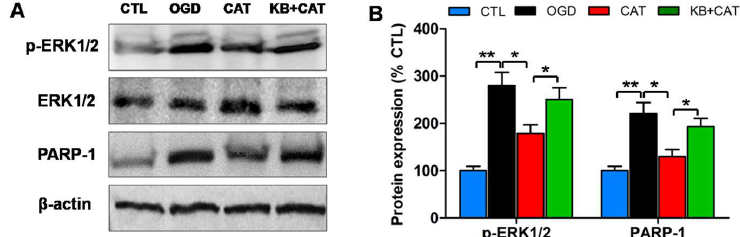
Figure 7. Effects of catalpol on the activation of the extracellular signal-regulated kinase 1/2 (ERK1/2) pathway in PreOLs under OGD and KB-R7943 treatment. ( A ) Western blot probing for p-ERK1/2 and poly-ADP-ribose polymerase-1 (PARP-1) from the CTL, OGD, CAT, and KB+CAT groups. Total ERK1/2 and β-actin were used as loading controls. The blot shown is representative of six independent experiments. ( B ) Quantification of p-ERK1/2 and PARP-1 protein expression levels from Western blot analyses. Data are shown as means ± SEM ( n = 6 in each group). * p < 0.05; ** p < 0.01.